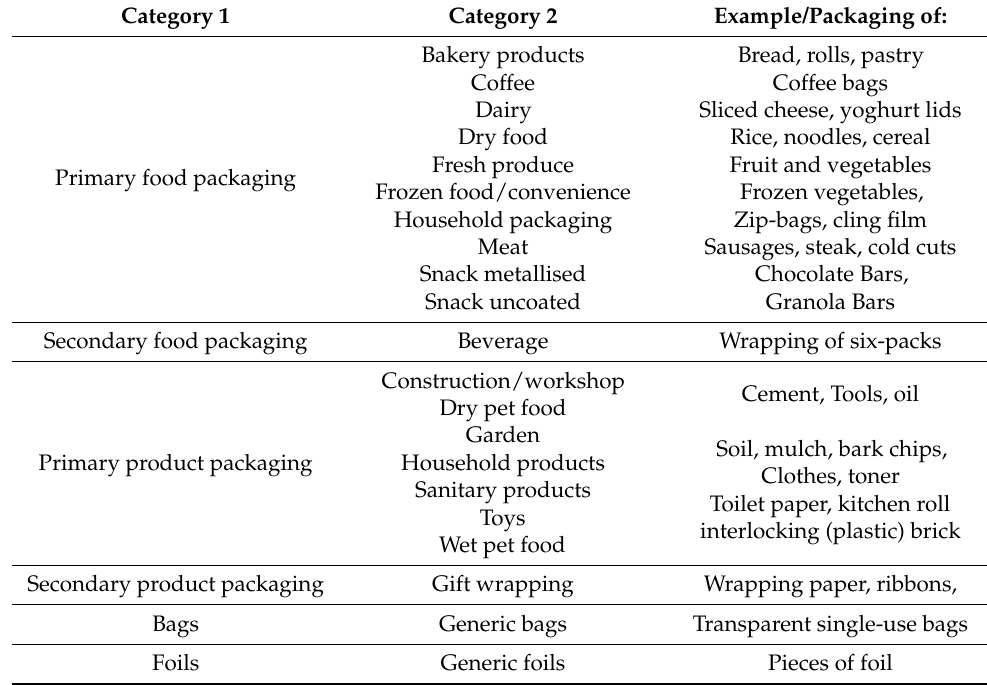
Table 1. Definition of sorting categories of application of two-dimensional plastic